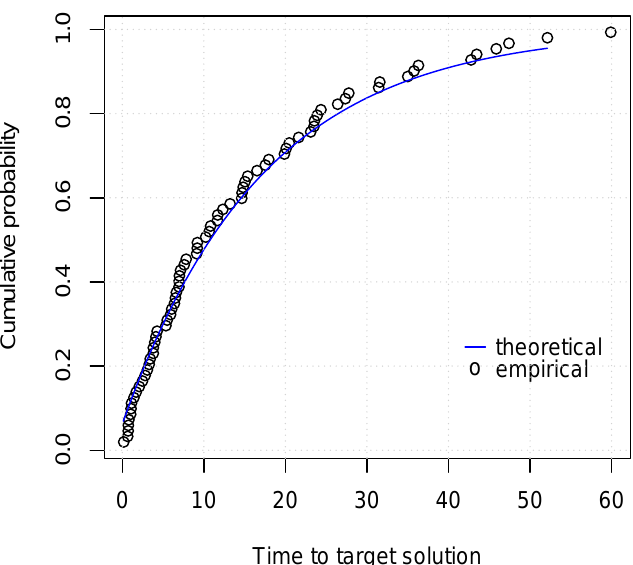
Figure 2. Time-to-target plot for an instance with 400 trips based on 75 independent runs of the GRASP